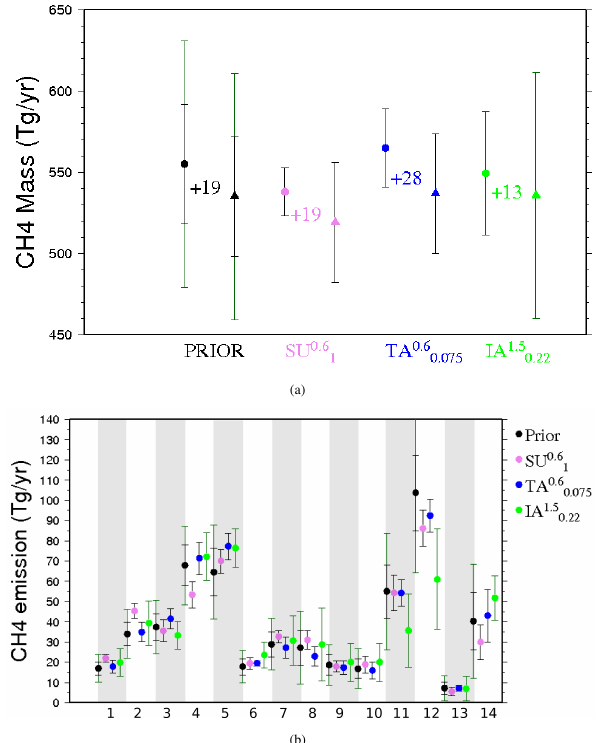
Fig. 10. Global emissions (circles) and losses (triangles) (a) and regional emissions (b) for the ”optimal” configurations TA 0 . 6 0 . 075 (blue), IA 0 . 6 0 . 22 (green) and SU 0 . 6 1 (violet). Numbers describe the global growth rates in Tg yr − 1 inferred by the inversions. Error bars represent either the prior uncertainties ( α =0 . 6 in black and α =1 . 5 in dark green), either the posterior uncertainties estimated with the Monte-Carlo study (see Section 2.1).